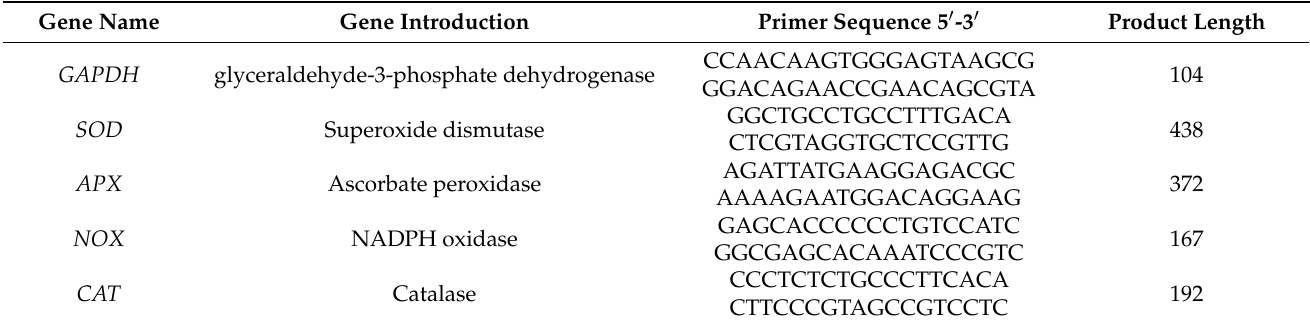
Table 1. Information about the genes and primers used in this